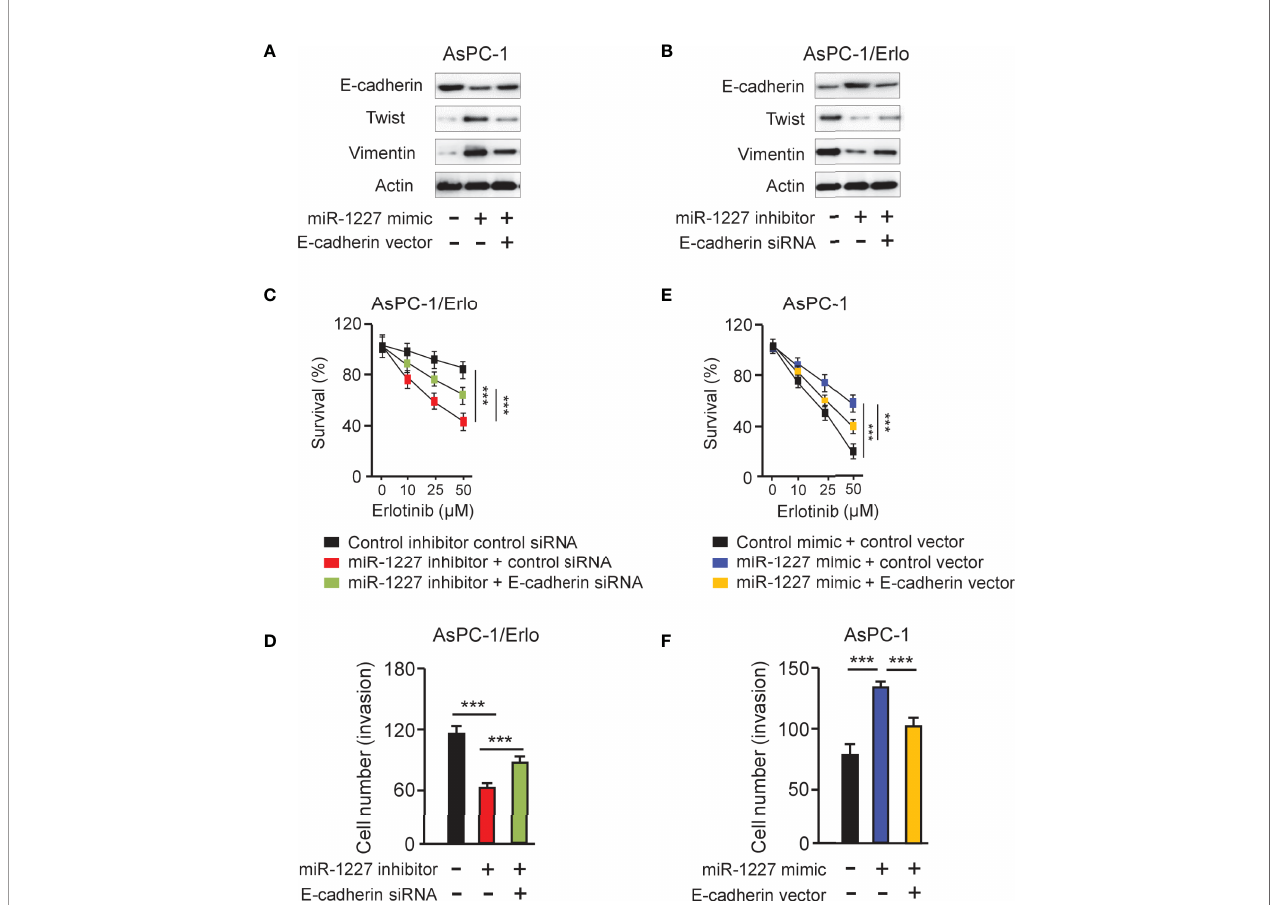
FIGURE 7 | MiR-1227 promotes erlotinib resistance and cell invasion via reducing E-cadherin expression. (A, B) Western blot analysis of E-cadherin, Twist, and Vimentin in AsPC-1 (A) and AsPC-1/Erlo (B) cells transfected as indicated. (C) AsPC-1/Erlo cells transfected as indicated were exposed to each concentration of erlotinib for 48 h, and the inhibitory effects of erlotinib were evaluated using CCK-8 assays. (D) AsPC-1/Erlo cells were transfected as indicated, and cell invasion was evaluated using cell invasion assays. (E) AsPC-1 cells transfected as indicated were exposed to each concentration of erlotinib for 48 h, and the inhibitory effects of erlotinib were evaluated using CCK-8 assays. (F) AsPC-1 cells were transfected as indicated, and cell invasion was evaluated using cell invasion assays. *** P